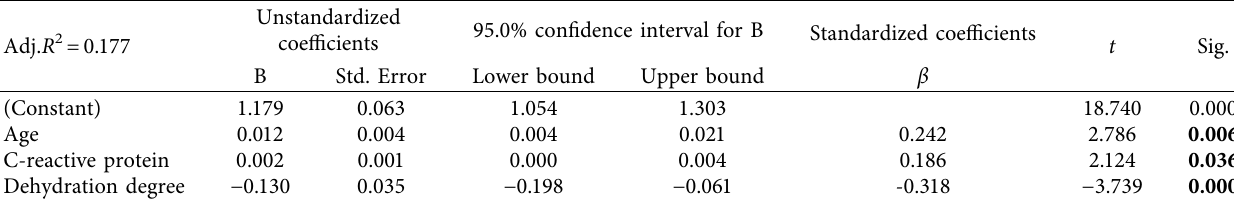
Table 4: Linear regression analysis of factors that effecting IVC/AO ratio.